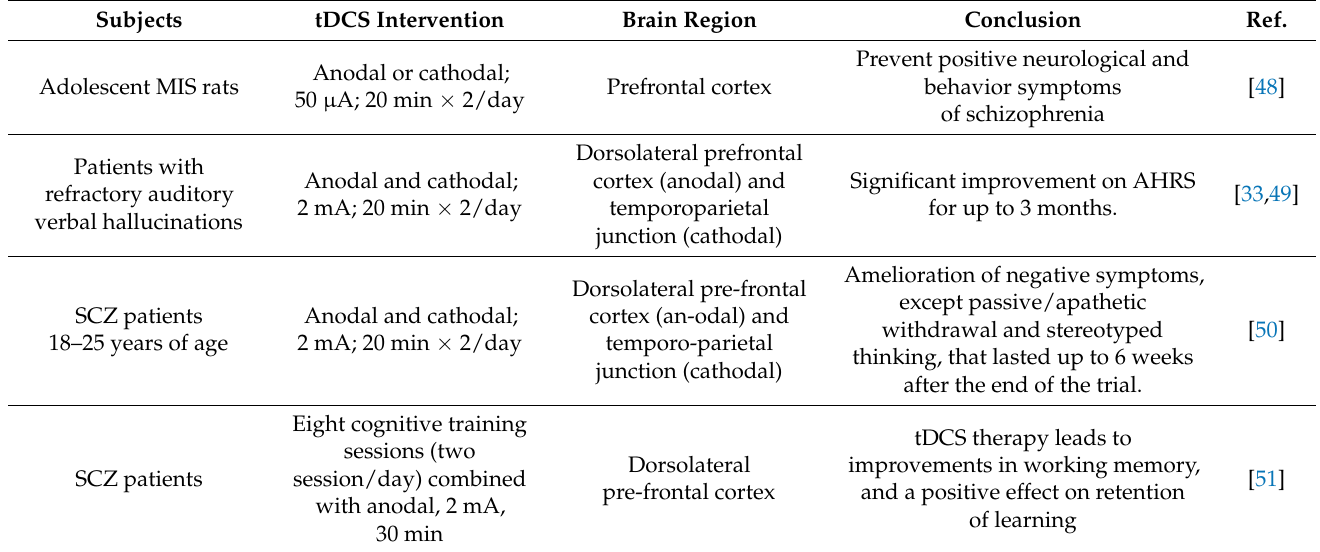
Table 2. Summary of studies on the effects of tDCS on Schizophrenia